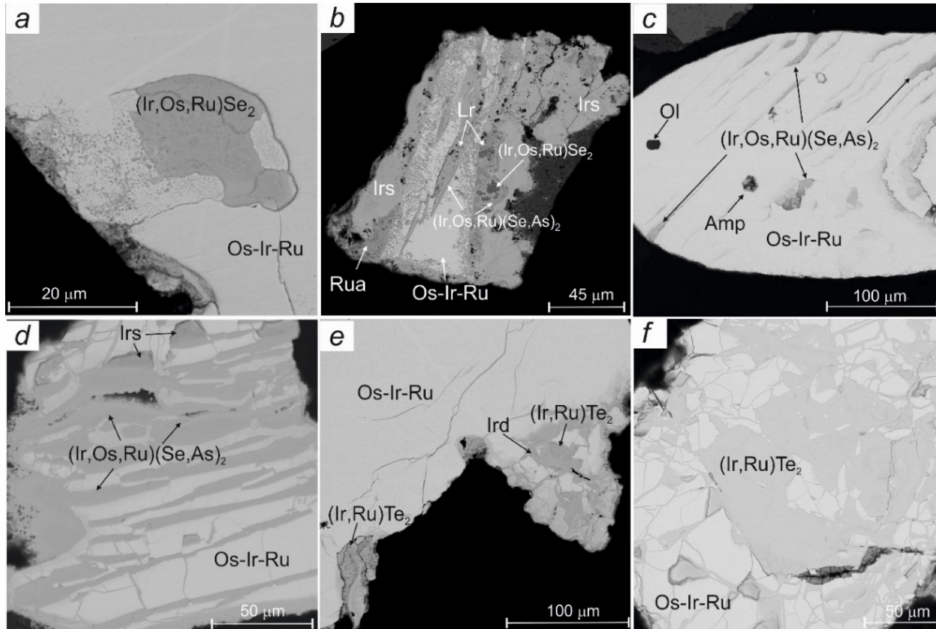
Figure 8. BSE images showing the development of alteration of secondary chalcogenides in Os-Ir-Ru alloys grains: ( a ) inclusion of IPGE selenide near the edge part; ( b ) grain is almost entirely replaced by laurite (Lr), irarsite (Irs), ruarsite, and selenium-containing compounds; ( c ) development of IPGE selenium-arsenides along microcracks in grain with inclusions of olivine and amphibole; ( d ) intensive development of irarsite (Irs), IPGE seleno-arsenides along microcracks in grain; ( e ) substitution of iridarsenite (Ird) by Ir-Ru telluride in the marginal part; ( f ) almost complete replacement of brecciated grain by Ir-Ru